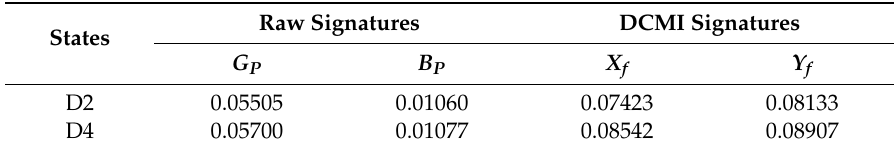
Table 5. Root mean square deviation (RMSD) based on raw signatures and DCMI signatures of specimen-1.